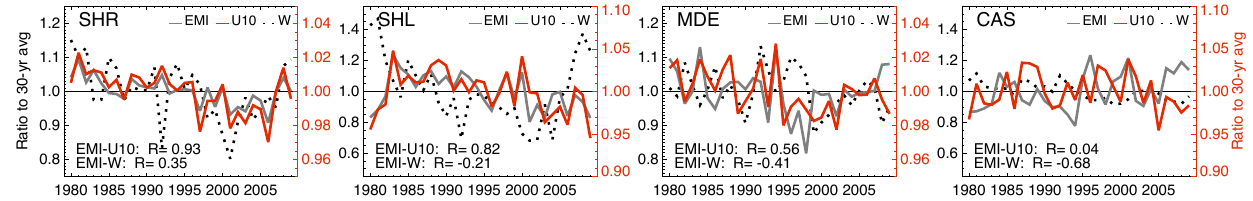
Fig. 13. Regional changes of GOCART dust emission (EMI, dark grey line) and its controlling parameters of 10m wind speed (U10, red line) and ground wetness ( W , dotted dark grey line) from MERRA from 1980 to 2009, expressed as ratios of annual averaged values to 30-year average, in four dust source regions of Middle East (top left), Central Asia (top right), Sahara (bottom left) and Sahel (bottom right). See Fig. 1 for region domains. Note the linear correlation coefficients on regional and annual average scale serve as indicators on the relative closeness between the emission and meteorological